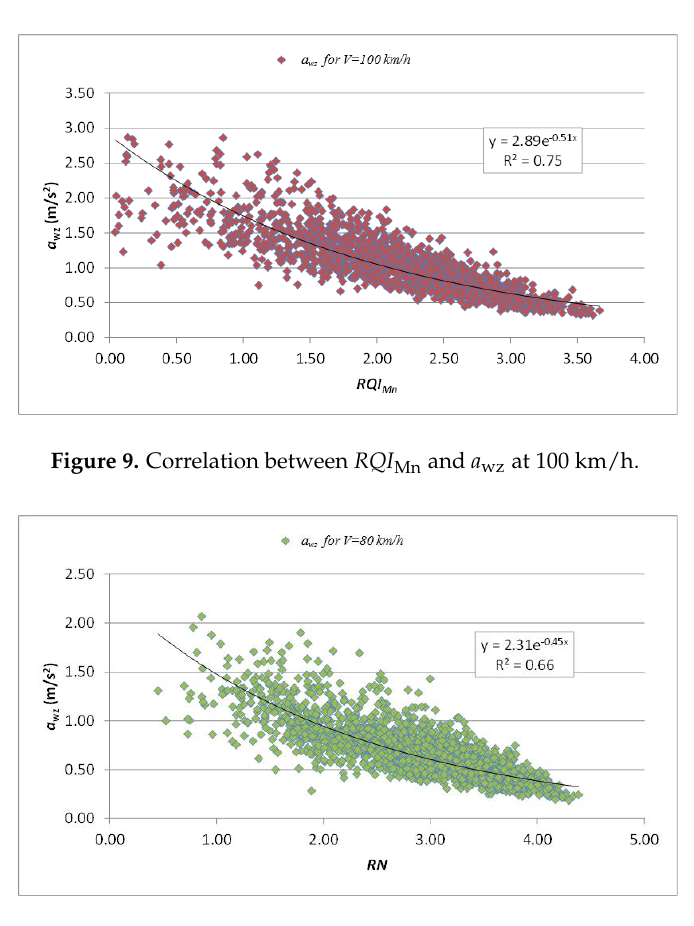
Figure 10. Correlation between RN and a wz at 80 km/h.